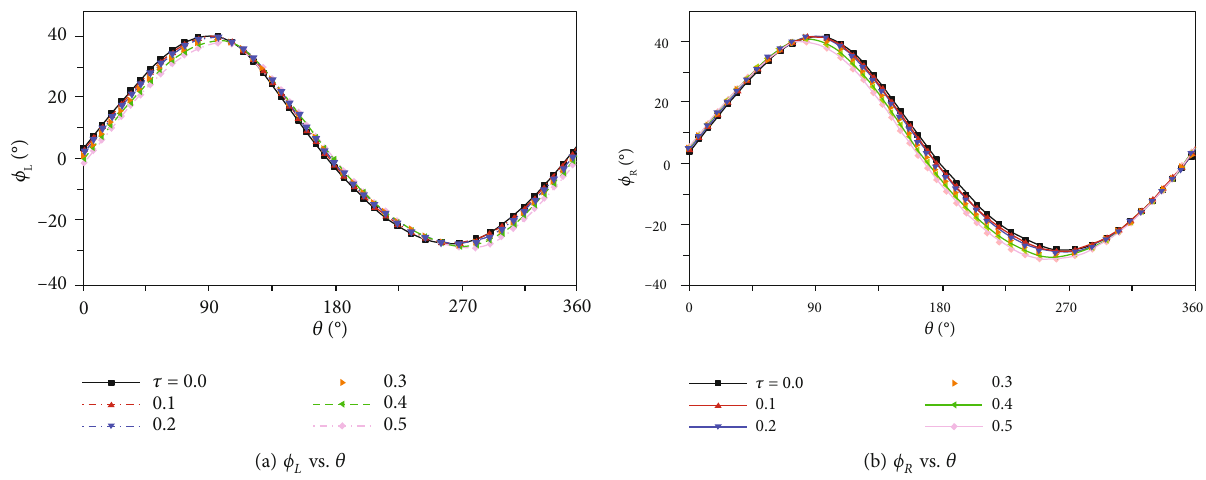
Figure 3: Relationships of ϕ